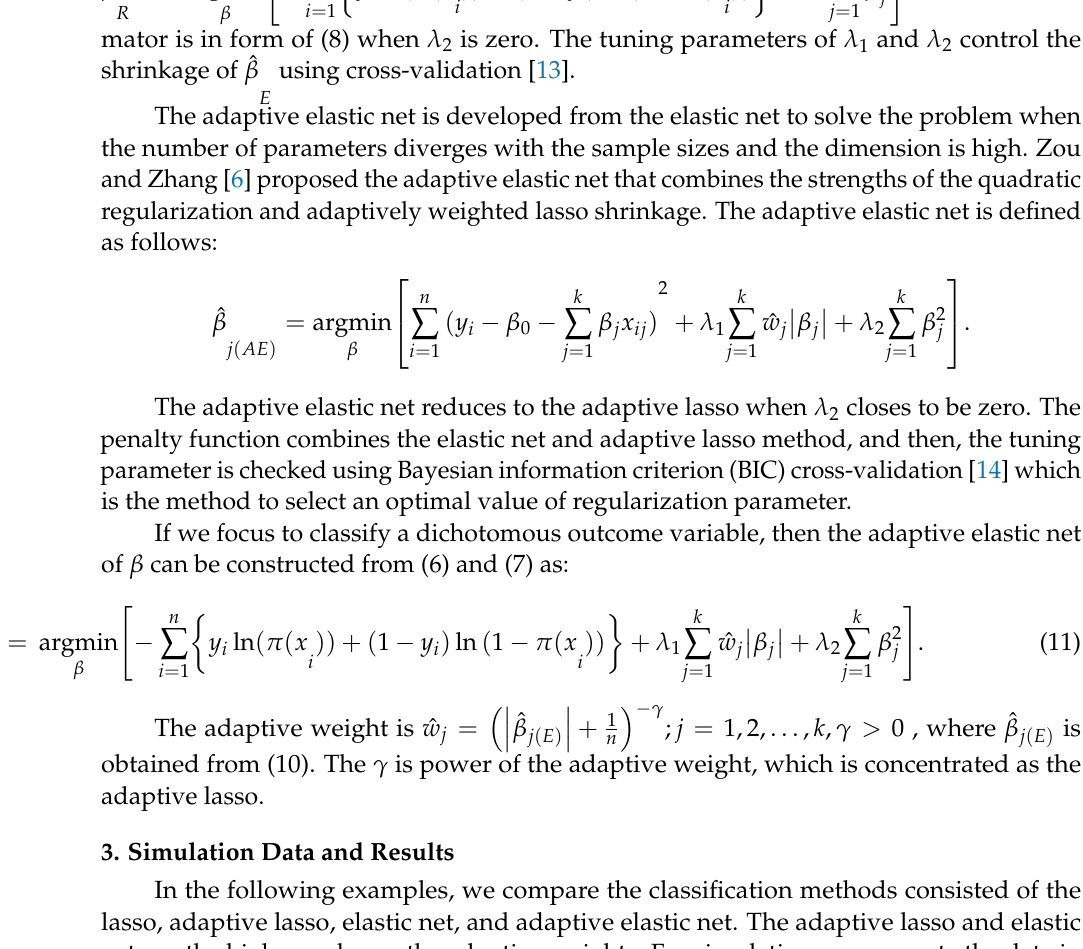
Figure 1. The normal probability density in